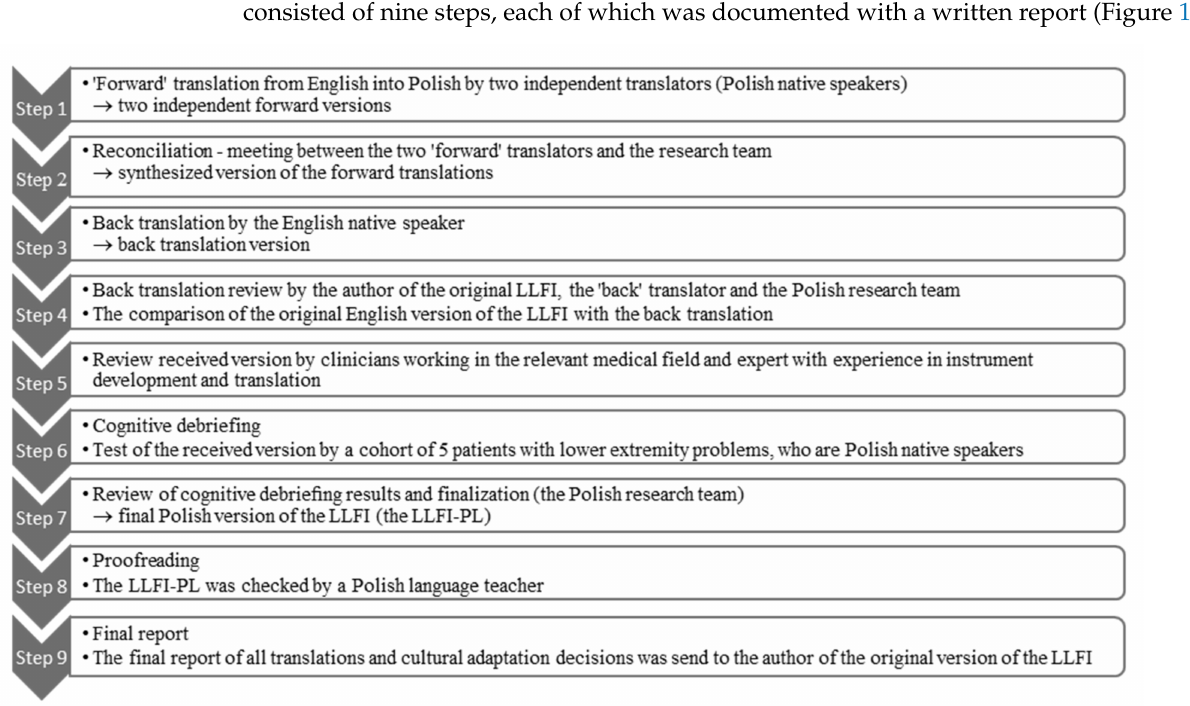
Figure 1. Flow chart of the translation and cultural adaptation process of the Lower Limb Functional Index from English to